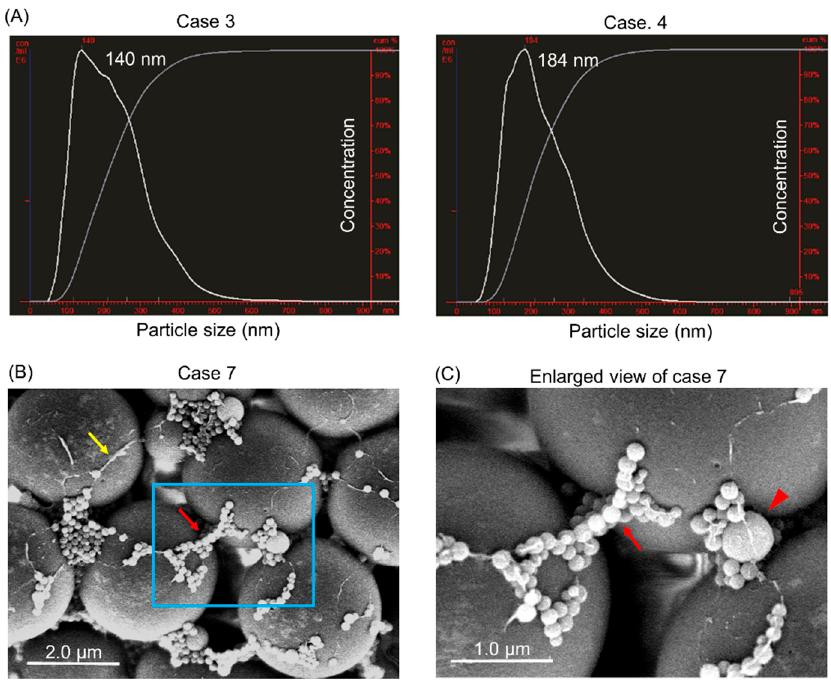
Figure 3. Isolates from GJ of GC patients contained EVs. ( A ) Size characterization of extracts from GJ by nanoparticle tracking analysis (NTA). The peak size of each sample is indicated in each graph. Four cases (cases 3–6) were examined, and representative graphs of cases 3 and 4 are shown; ( B , C ) Morphological study using scanning electron microscope (SEM). Three cases were examined. ( B ) SEM of the isolates from case seven. Red arrow indicate EVs on microbeads; and yellow arrow, mucus; area boxed in blue is enlarged in ‘’C”. Scale bar = 2.0 µ m; ( C ) Enlarged view of extracts is boxed in blue in ( B ). Red arrowhead: EVs more than 100 nm. Red Arrow: EVs less than 100 nm. Scale bar = 1.0 μ m.